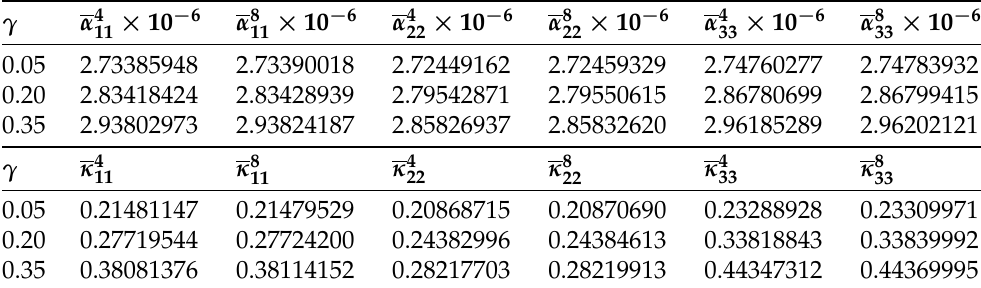
Table 7. Calculated effective thermal coefficients ( α and κ ) for the Nicalon/BMAS composite material with elliptical cross-section